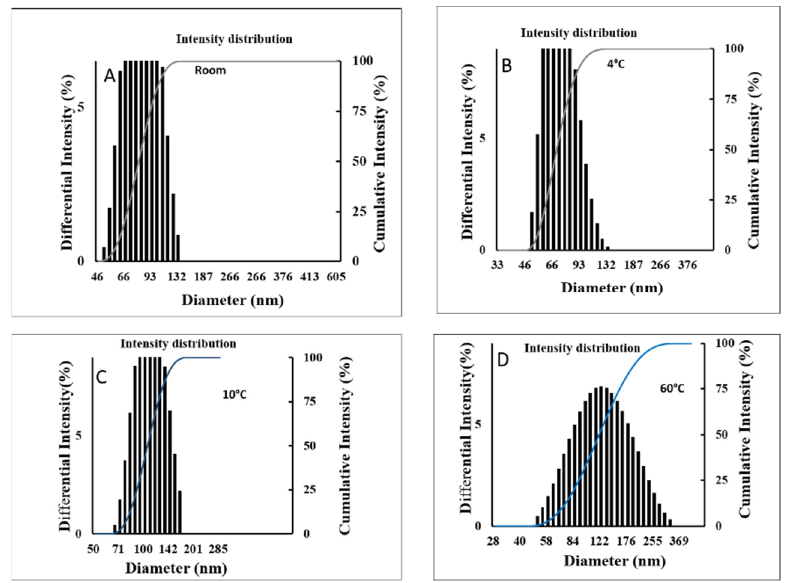
Figure 1. DLS analysis analyzed the size of Panos nanoemulsion indifferent stored temperatures ( A ) Room temperature ( B ), 4 °C ( C ), 10 °C ( D ).